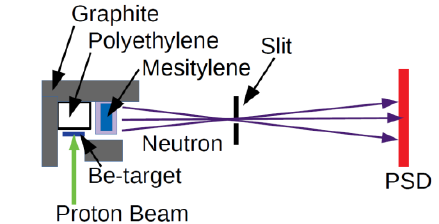
Fig. 1. Experimental set-up of the present